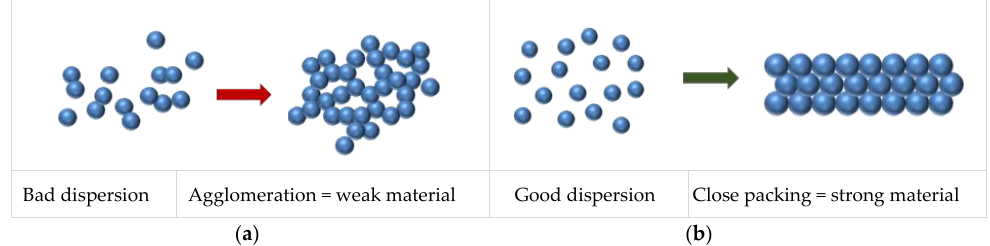
Figure 1. The influence of particle dispersion on properties on sintered ceramics: ( a ) bad dispersion and ( b ) good dispersion